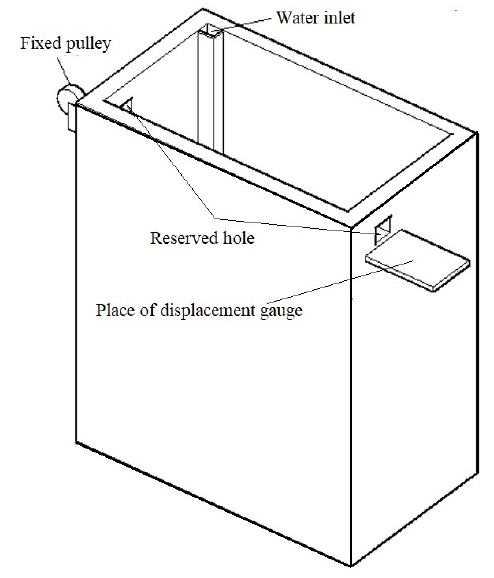
Figure 1. Model Figure 1. Model box.